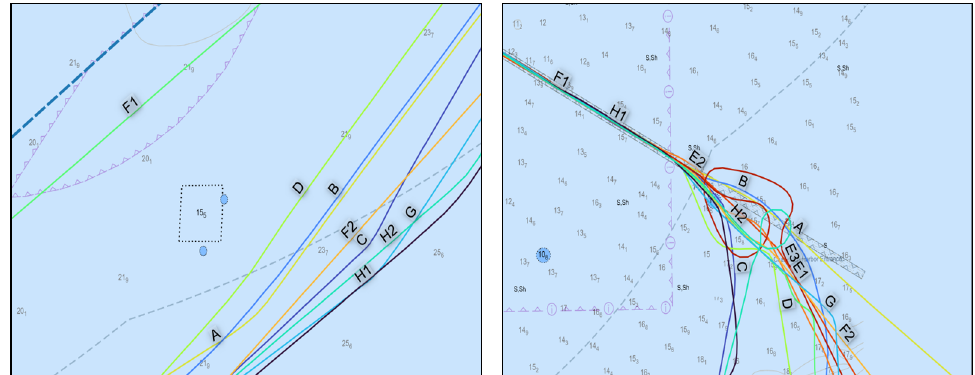
Figure 9. Fish haven obstructions (buoys not shown) with depth of 15.5 m ( left ) and approach area ( right ) for port of Charleston (scale 1:50000).